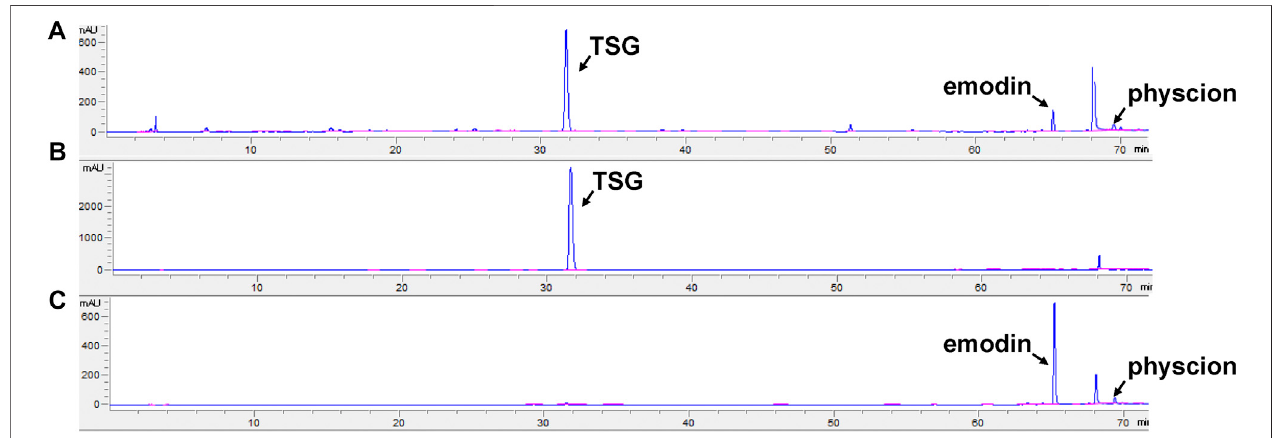
FIGURE 1 | HPLC chromatogram. (A) RPMP ethanol extract. (B) TSG. (C) emodin and physcion.